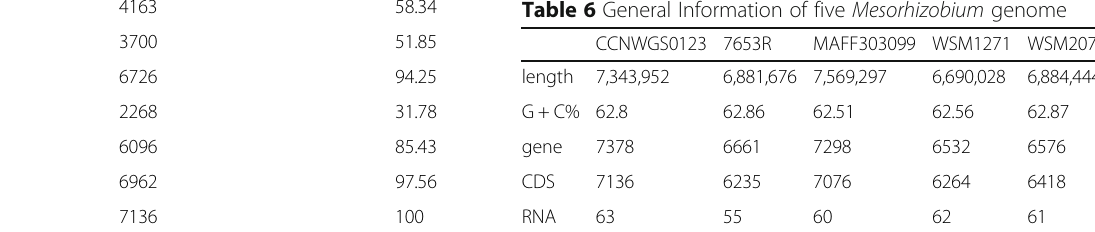
Table 5 Function annotation assignment from different databases Database